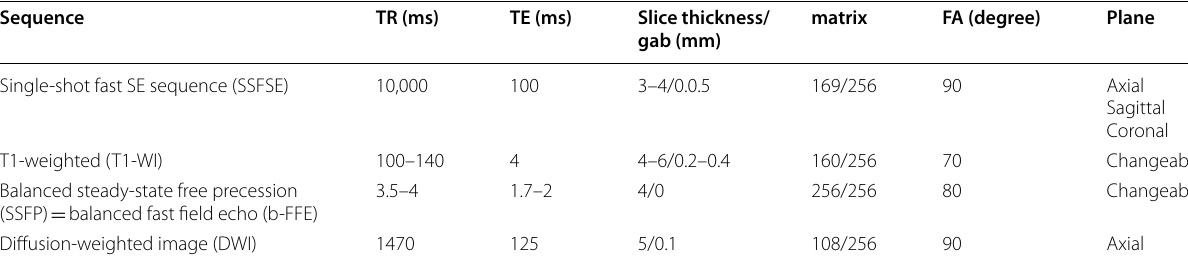
Table 1 Parameters in fetal MRI sequence